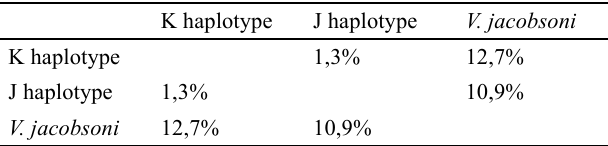
Table 2 . Level of divergence (in percentage) between the different Varroa destructor COI haplotypes and Varroa jacobsoni . This table includes the Korean haplotype (widely found in this study), the Jap- anese haplotype (found only in four Brazilian municipalities) and the V. jacobsoni sequence (Vj, accessions AF106909.1).